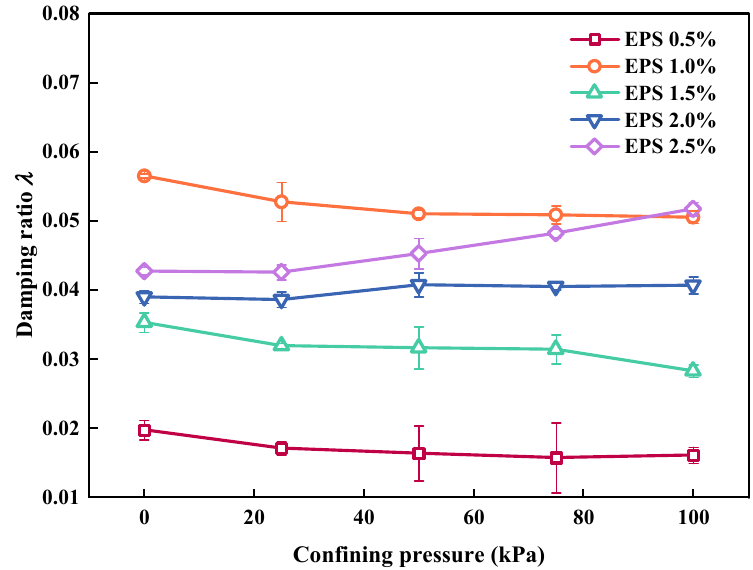
Figure 11. Relationship between con fi ning pressure σ 3 and λ .